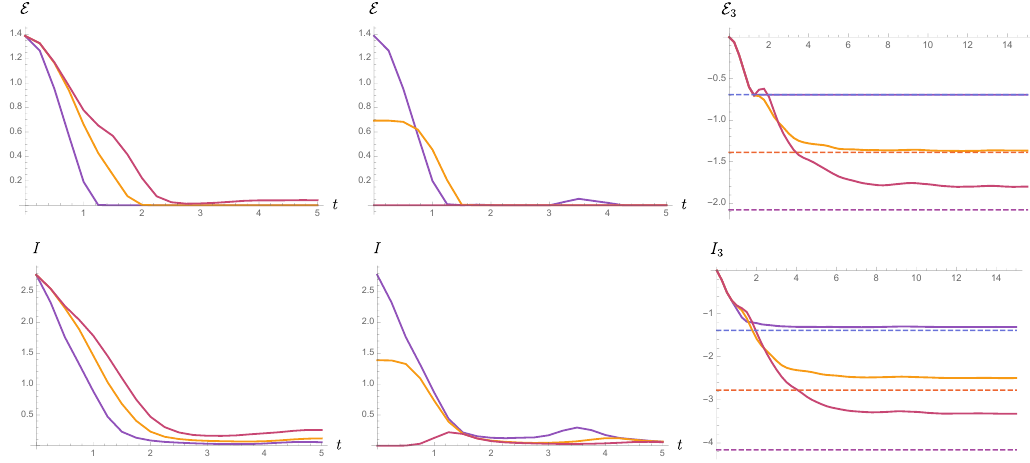
Figure 11 . The operator entanglement is shown for the chaotic spin chain corresponding to Hamiltonian (3.47) with g = (cid:0) 1 : 05, h = 0 : 5. (left) the BOLN and BOMI for overlapping intervals. The input interval is length 2 and the output varies as length 2 (purple), 3 (yellow), 4 (magenta) with the same starting position as the input interval. (center) the BOLN and BOMI for intervals of length 2 fully overlapped (purple) partially overlapped (yellow) and adjacent (magenta). (right) the TOLN and TOMI for input intervals of lengths 1 (purple), 2 (yellow), and 3 (magenta). The union of the other two intervals compose the entire output system. The dotted lines are the lower bounds for the TOLN and TOMI. We have seven input and output spins in all